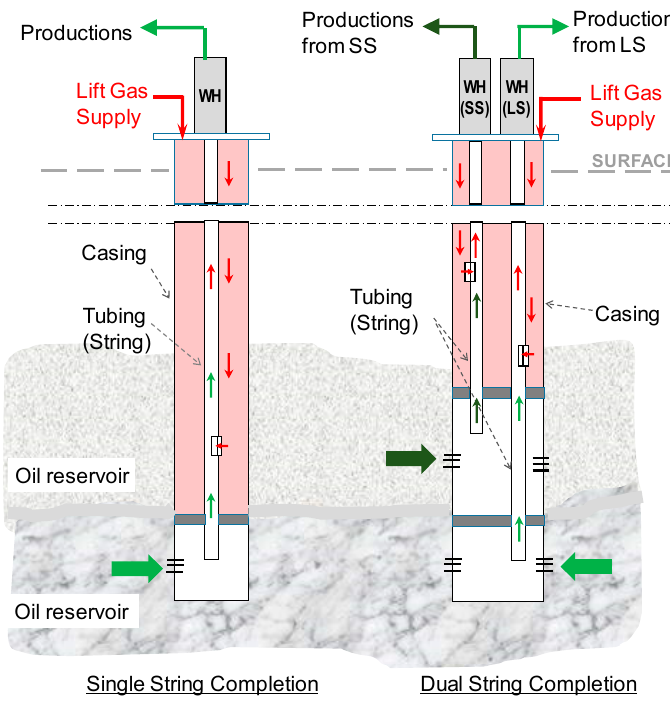
Figure 1. Single string and dual string completions.